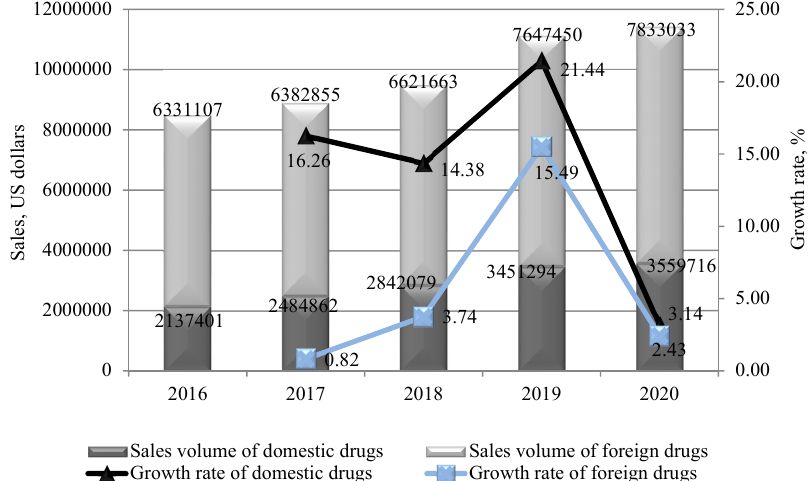
Fig. 6. Dynamics of indicators of retail sales of antiepileptics in cash for the pharmaceutical market of Belarus